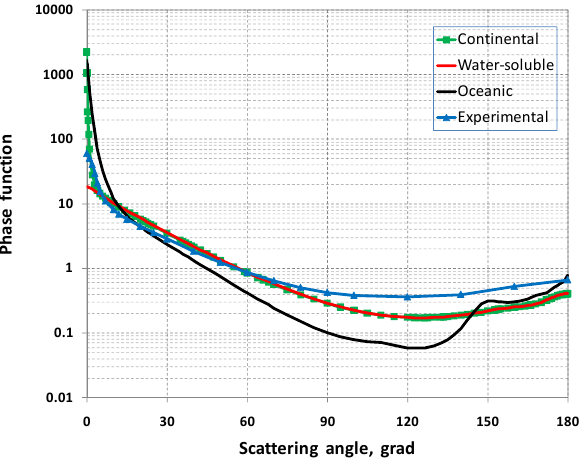
Fig. 19. Phase functions of different aerosol types at λ = 550nm.